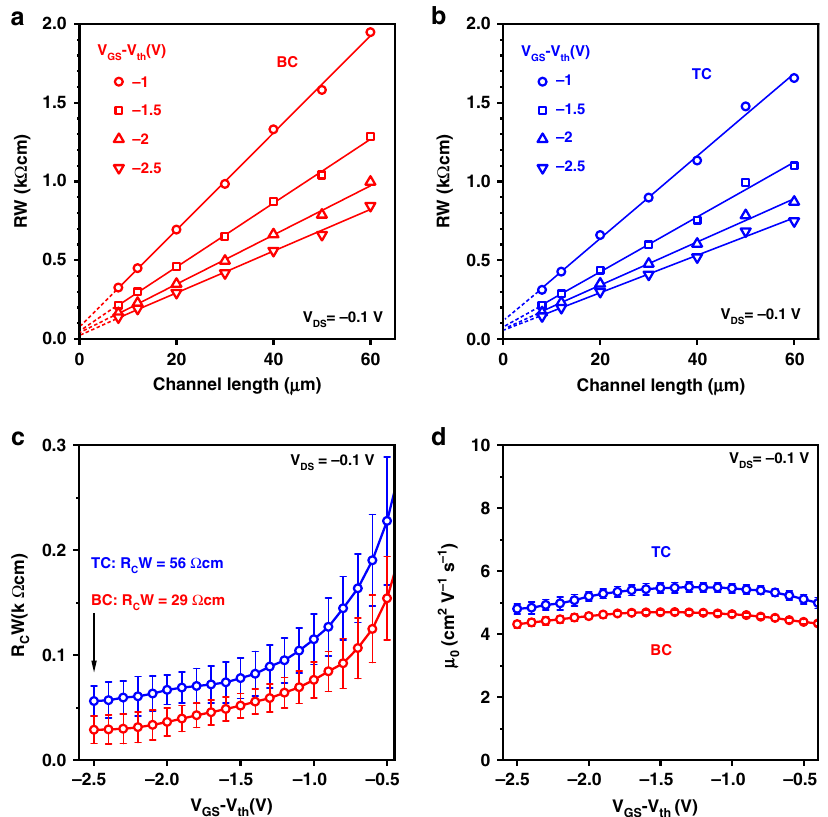
Fig. 5 TLM analysis of bottom-contact and top-contact DPh-DNTT TFTs fabricated on fl exible PEN substrates. The TFTs have a gate-dielectric thickness of 5.3 nm, channel lengths ranging from 8 to 60 µ m, and a channel width of 200 µ m. a , b Linear fi ts to the total width-normalized resistance ( RW ) at selected gate-overdrive voltages ( V GS − V th ). c Width-normalized contact resistance ( R C W ) plotted as a function of the gate-overdrive voltage. The error bars correspond to the standard error from the linear regression at each gate-overdrive voltage. d Intrinsic channel mobility ( µ 0 ) plotted as a function of the gate-overdrive voltage